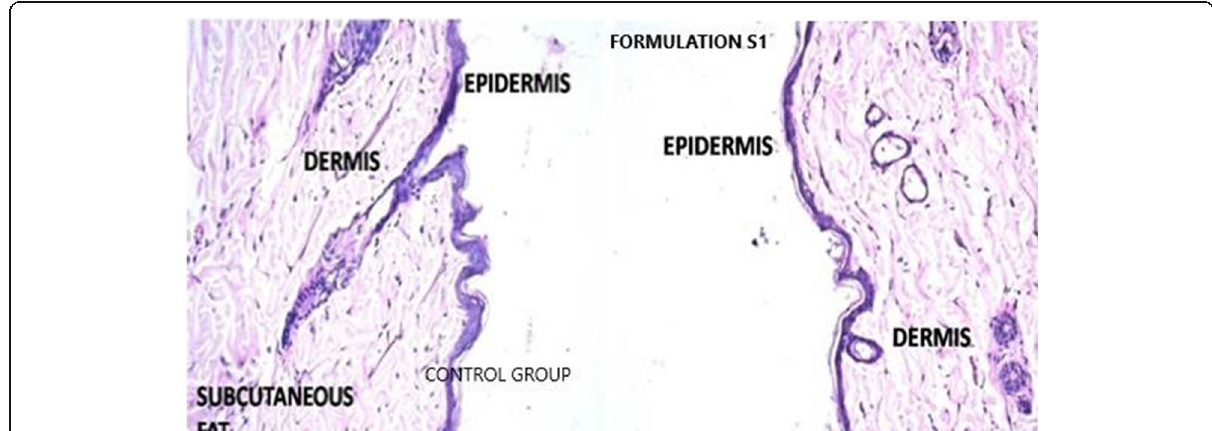
Fig. 4 Histopathology section of rat skin of control group and of treated group received formulation S1